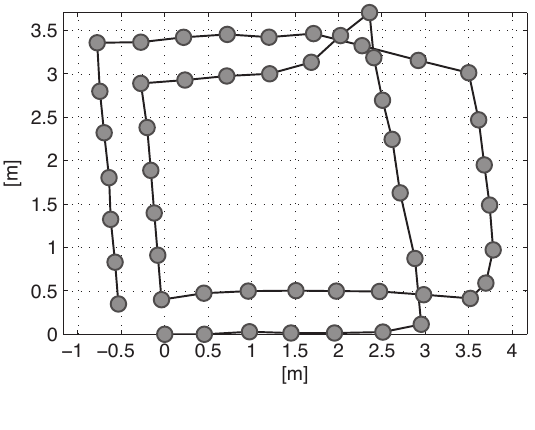
Figure 7. Distorted trajectory by the conventional graph SLAM algorithm due to a low dynamic